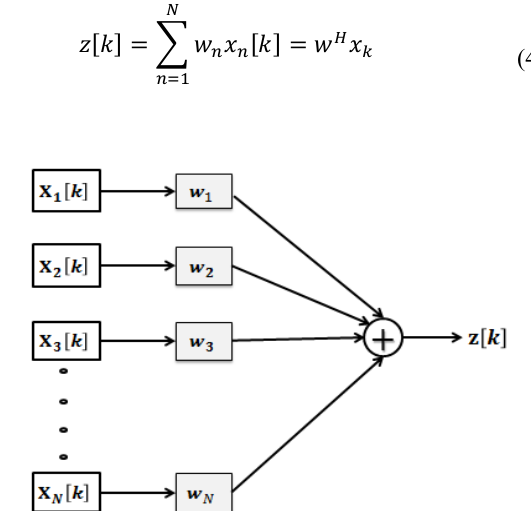
Figure 2: Illustration of Delay-And-Sum